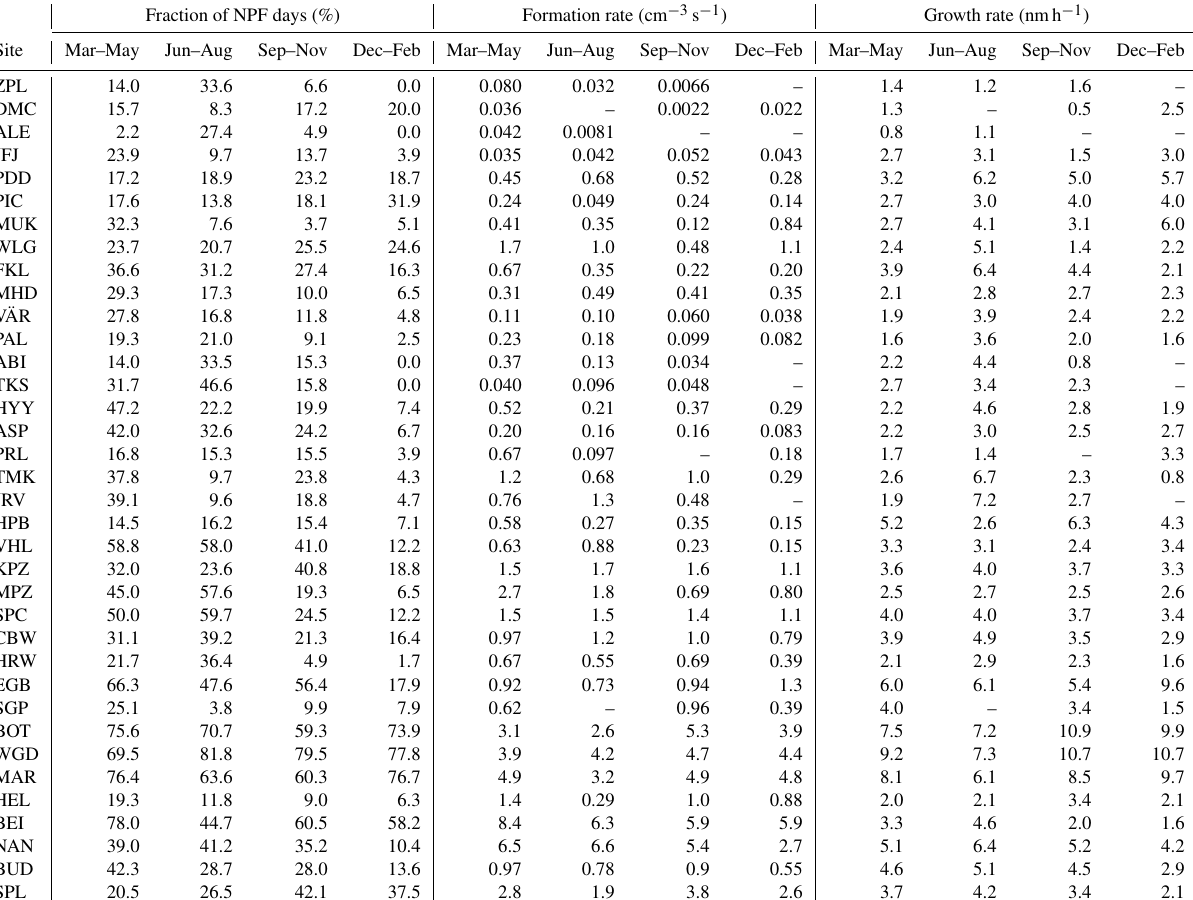
Table 2. Site-specific seasonal-median values of NPF event frequencies (fraction of class I and II NPF days from all the days with measure- ment data) and nucleation-mode particle formation and growth rates. A value is not given (indicated by –) if there were fewer than three quantifiable NPF events in any given